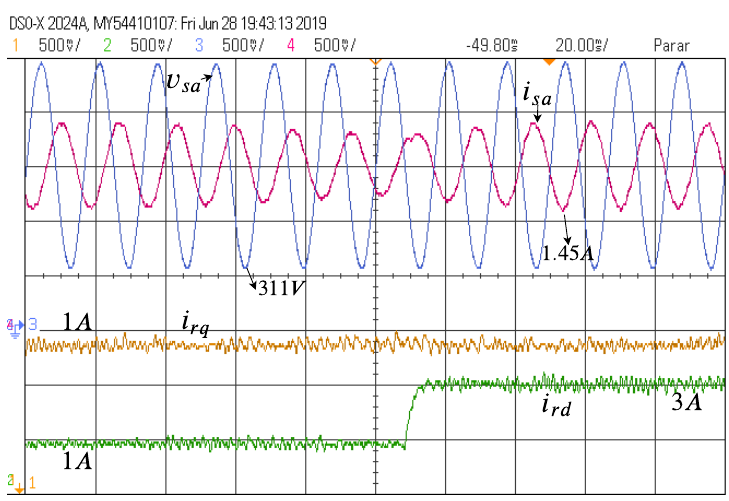
Figure 8. Voltage and current of stator in phase A , considering an i rd